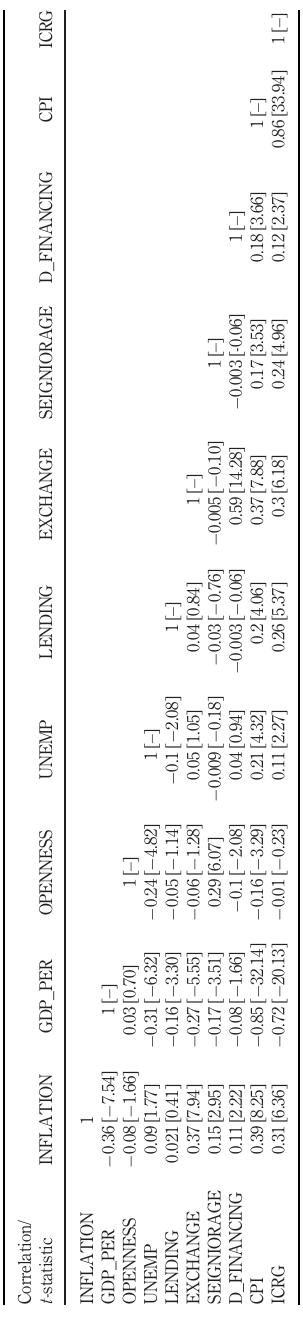
Table AII. The correlation and corresponding t